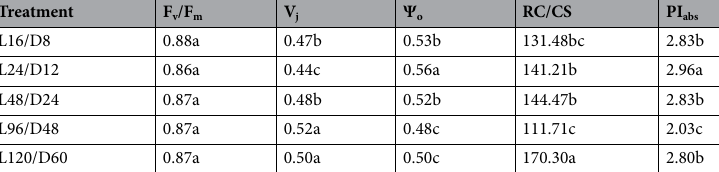
Table 3. The chlorophyll fluorescence parameters of lettuce leaves exposed to different L/D cycle treatments of RB. Values for the same parameter with different letters significantly differ at the 5% level (by Tukey’s test, n = 3). F v /F m —the maximum photochemical efficiency of PSII under dark adaptation; V j —relative variable fluorescence of J point; Ψ o —probability of the trapped exciton transferring electrons to other electron acceptors downstream of QA - in the electron transfer chain; RC/CS—the density of active reaction centers per unit area; PI abs —the performance index based on absorbed optical energy. L/D—light/dark. L16/D8—16 h light/8 h dark, L24/D12—24 h light/12 h dark, L48/D24—48 h light/24 h dark, L96/D48—96 h light/48 h dark, L120/D60—120 h light/60 h